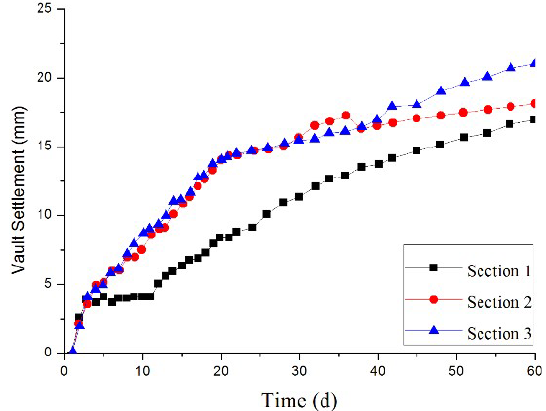
Figure 19. Settlement–time curve of the ground surface (bench method with the composite cantilever support